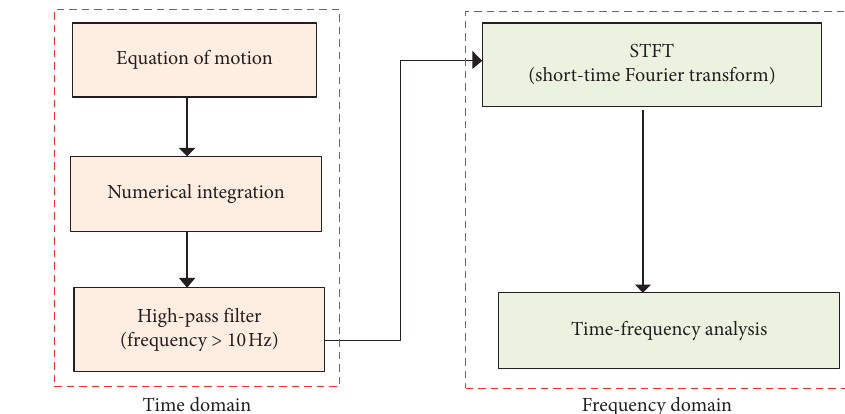
Figure 6: Calculating process.